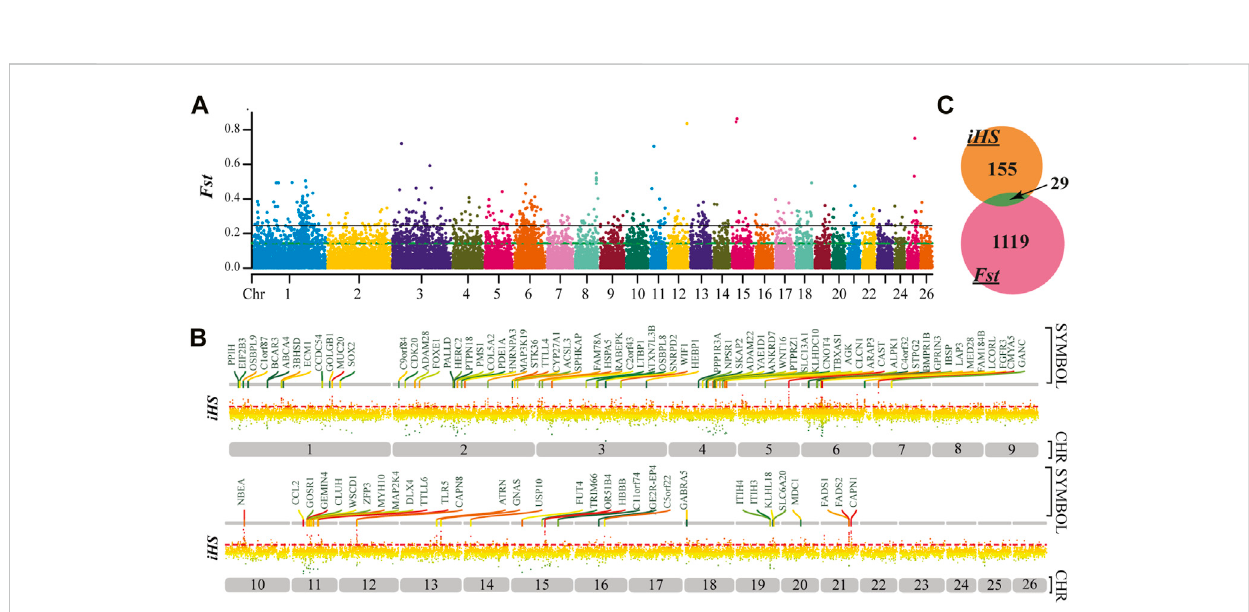
FIGURE 3 Selective gene sweep. (A) , F ST detection results of PRS and QR. The black line represents the 1% threshold line and the green line represents the 5% threshold line. (B) , The 100 high-rank genes under the iHS 1% threshold. (C) , The intersection of F ST and IHS